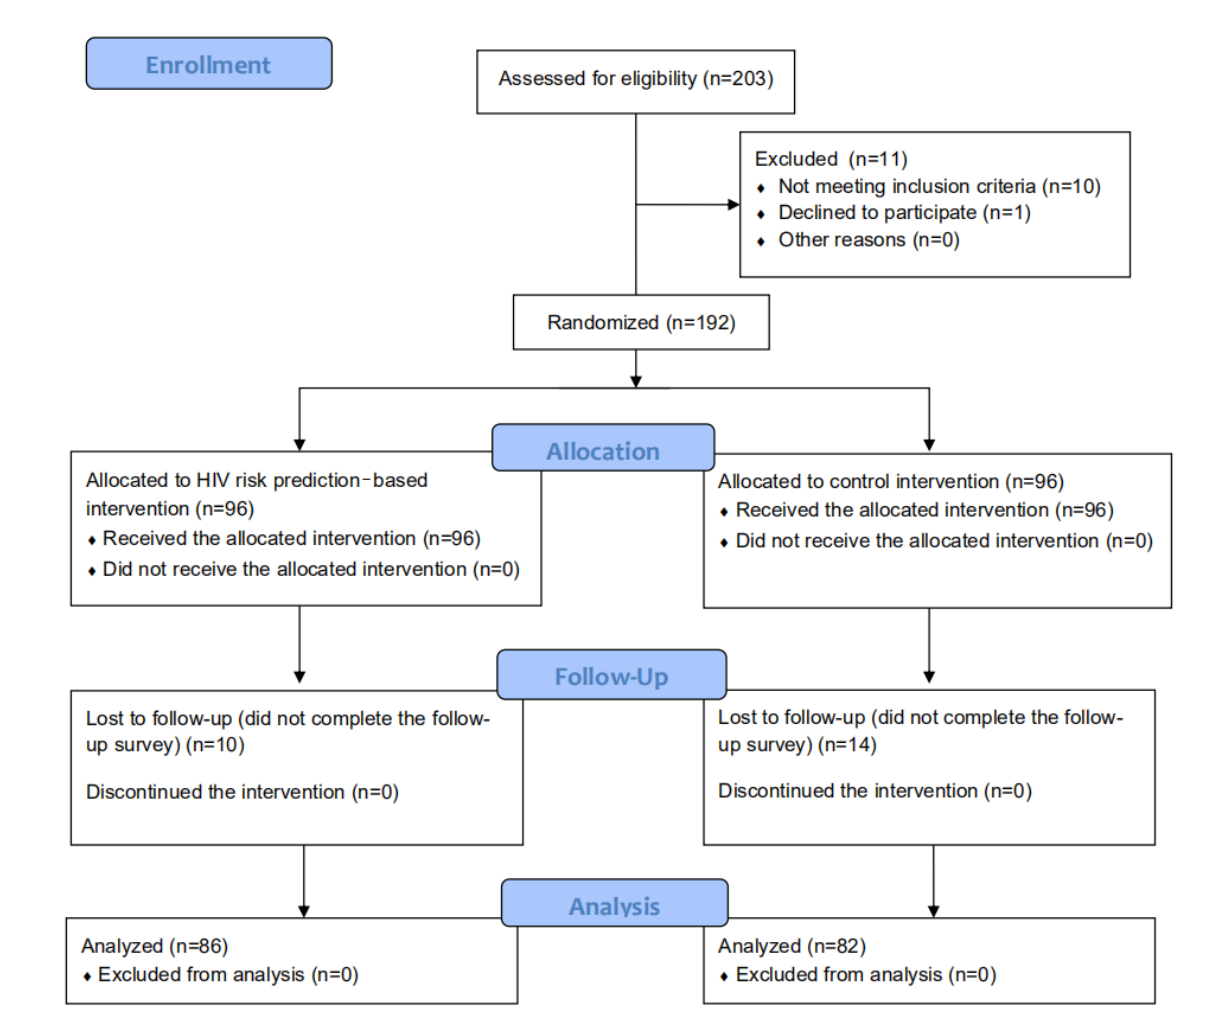
Figure 1. Consolidated Standards of Reporting Trials flowchart for the recruitment of participants who are men who have sex with men in Shenyang,